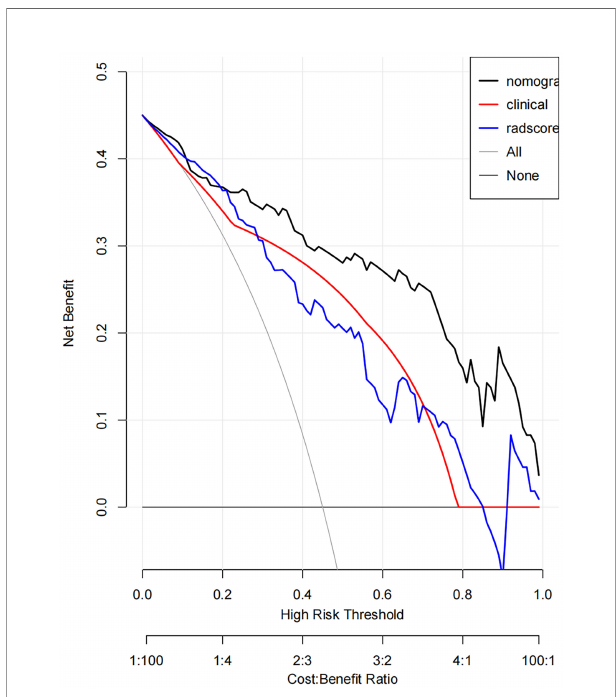
all SNSCCs were NER).